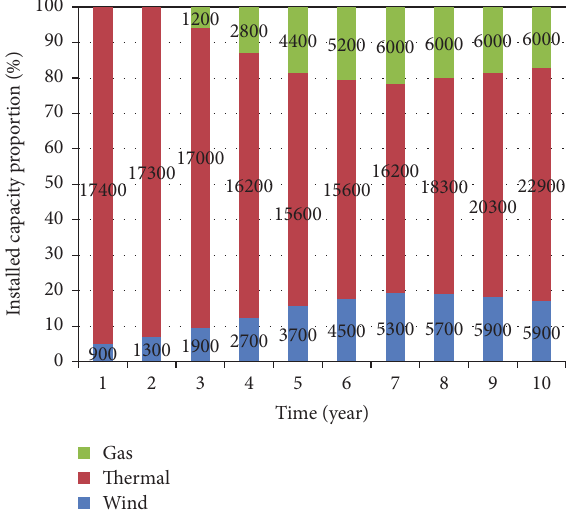
Figure 4: Structure of interregional installed capacity.